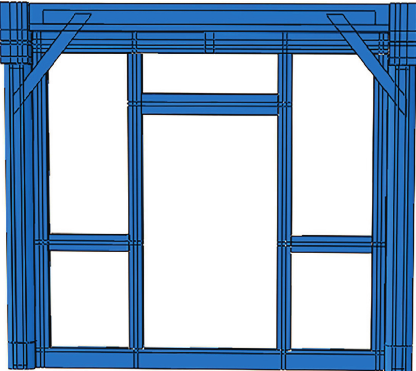
Figure 12: Reinforced wooden door frame